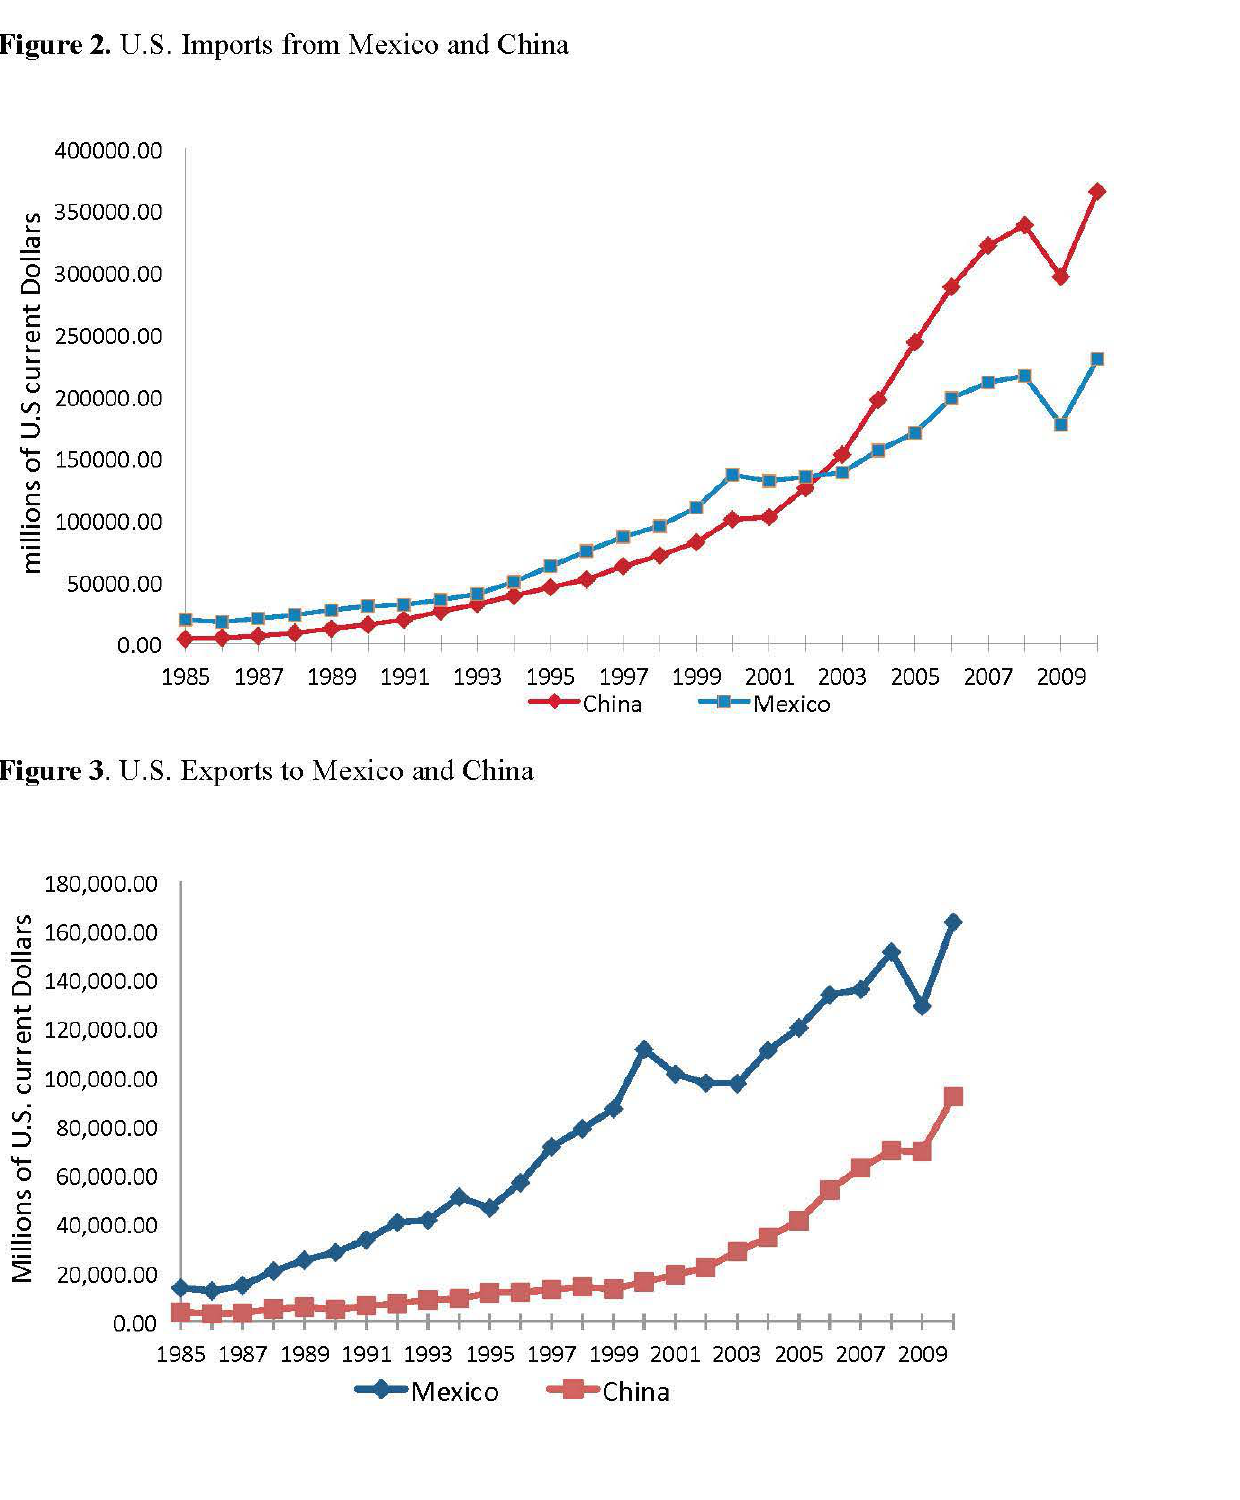
Figure 2. U.S. Imports from Mexico and China